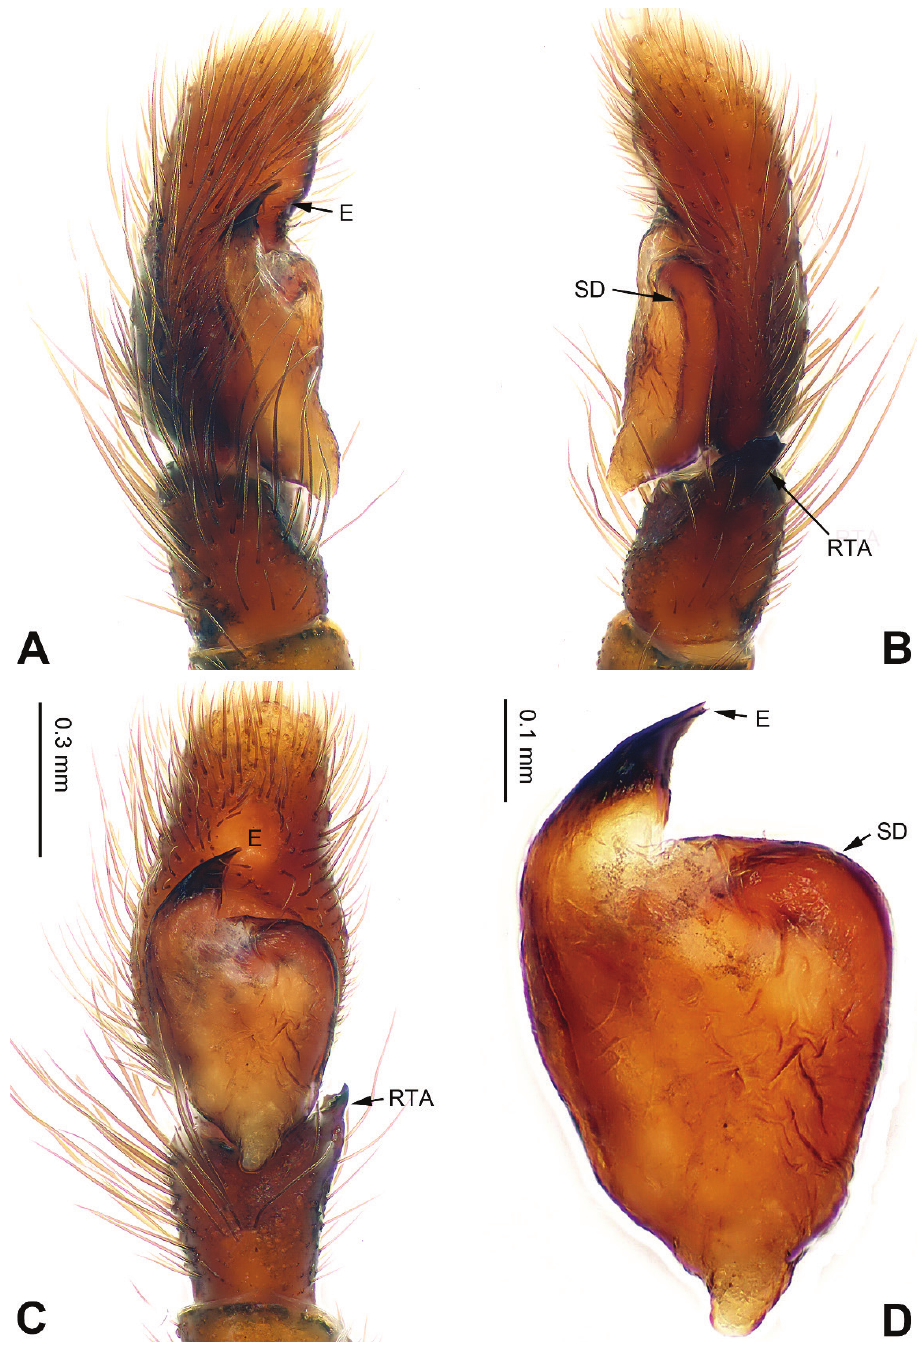
Figure 30. Palp of Pancorius latus sp. n., male holotype. A prolateral B retrolateral C ventral D bulb, ventral. Scale bar equal for A–C